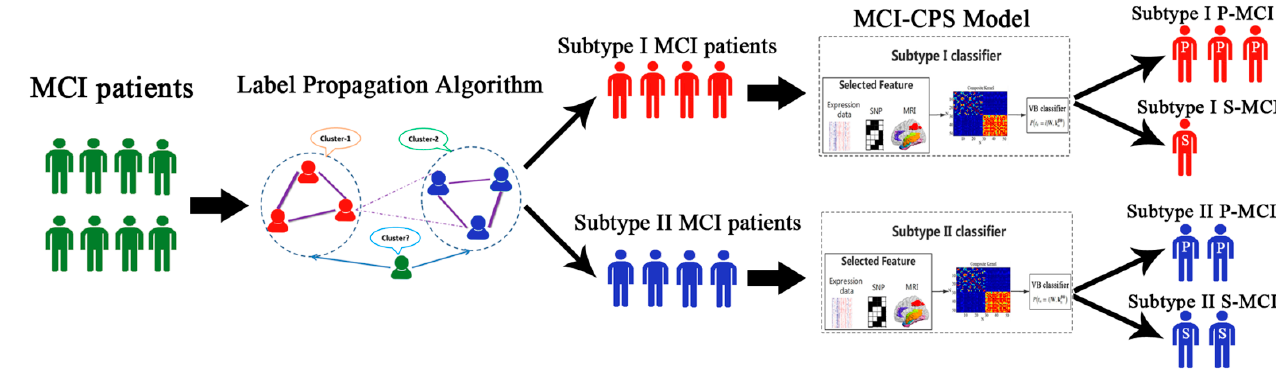
Figure 1. Overview of MCI conversion prediction based on subtyping (MCI-CPS) strategy. Label propagation algorithm is applied to predict subtypes of new patients. Classification of MCI patients in subtype I or II is based on structural magnetic resonance imaging (sMRI), single nucleotide polymorphism (SNP) and mRNA expression data. Multiple kernels learning method is utilized to embed feature sources into the composite kernel. In the construction composite kernel space, MCI patients are classified by variational Bayes approximation algorithm to predict whether conversion from MCI to AD will happen in three years.